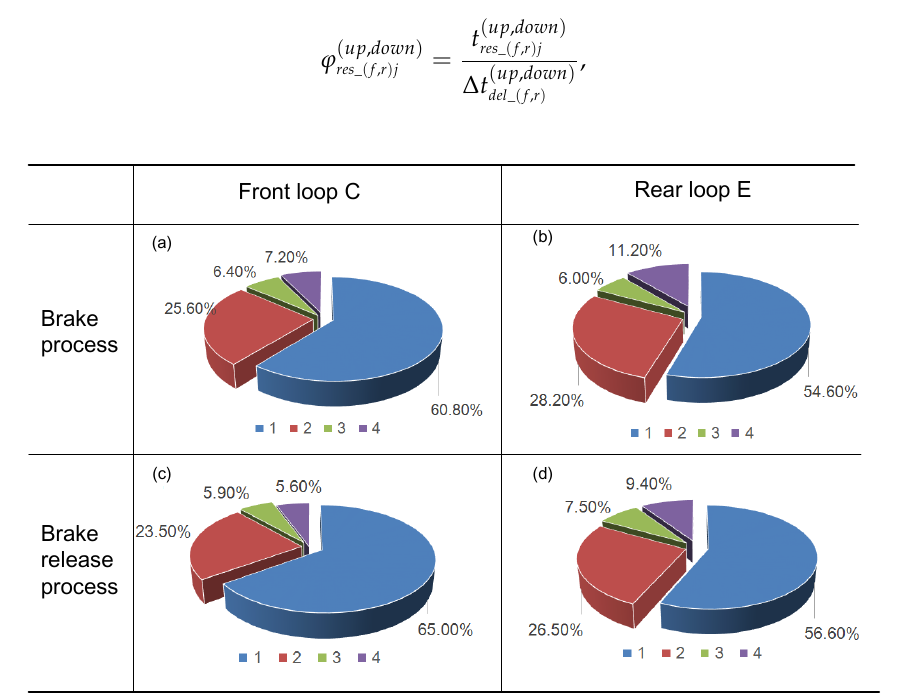
Figure 16. Response time of each subassembly in brake release process under the testing condition from group 1 to group 5, shown in ( a – e ), respectively. j = 1, 2, 3, 4. Finally, the proportion of response time of each subassembly can be calculated using the following formula and the corresponding results are shown in Figure 17.